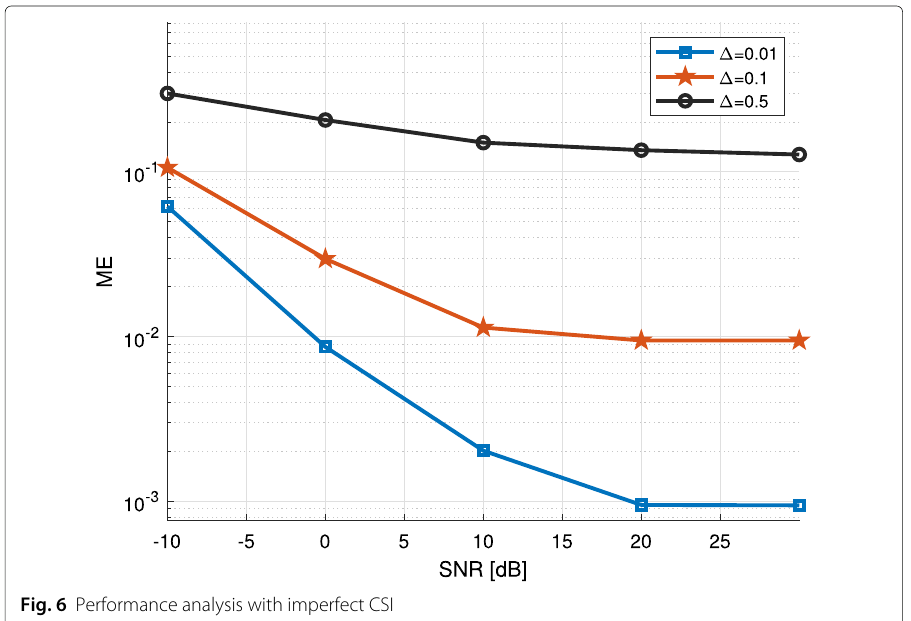
Fig. 6 Performance analysis with imperfect CSI